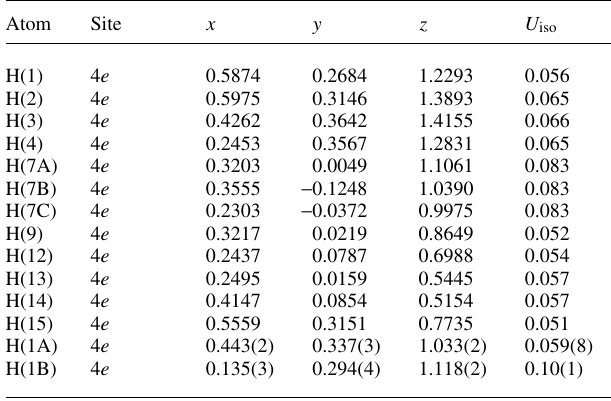
Table 2. Atomic coordinates and displacement parameters (in Å 2 )